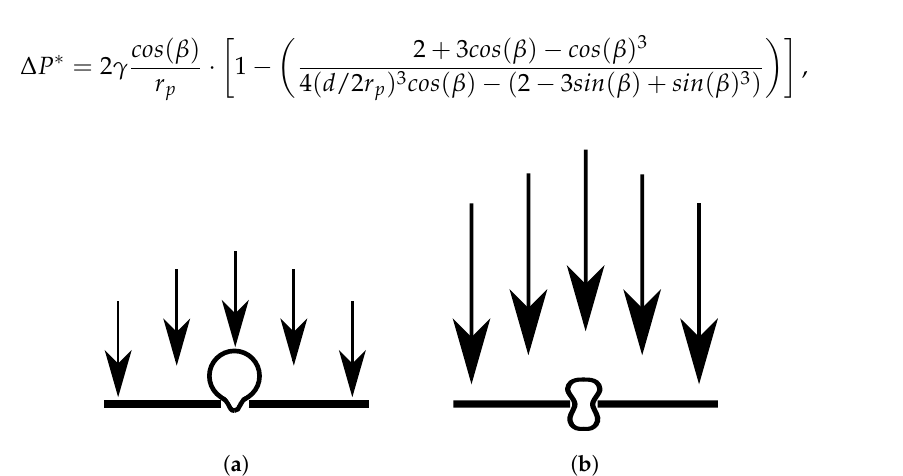
Figure 2. Oil droplet with sufficient and insufficient driving pressure to overcome interfacial tension. ( a ) Insufficient driving pressure; ( b ) Sufficient driving pressure.